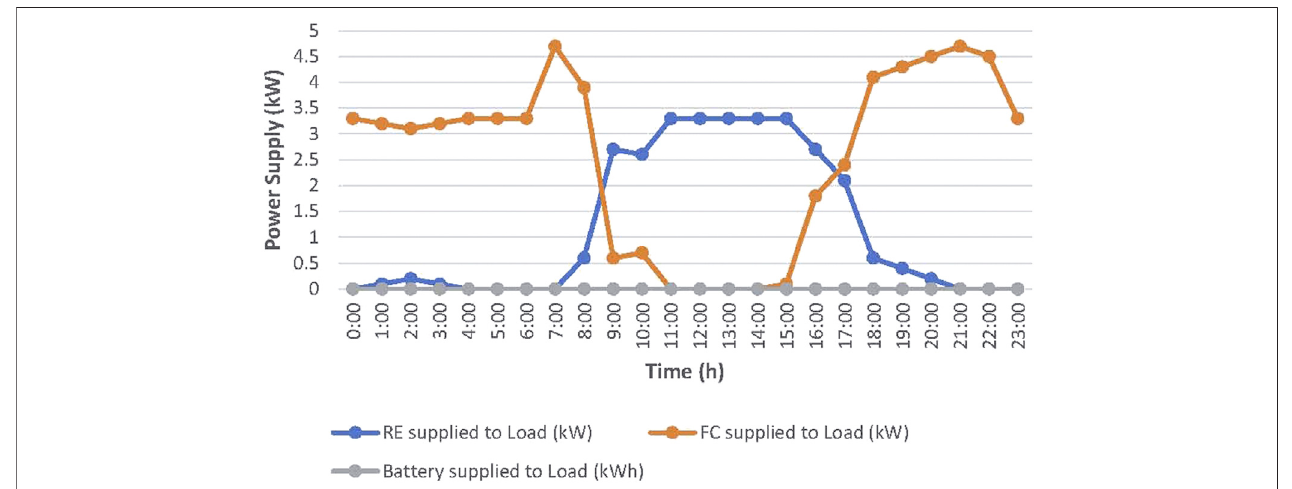
FIGURE 8 | Power Supplied by the Renewable Energy, Fuel Cell, and Battery to satisfy the Load Demand in Day 2